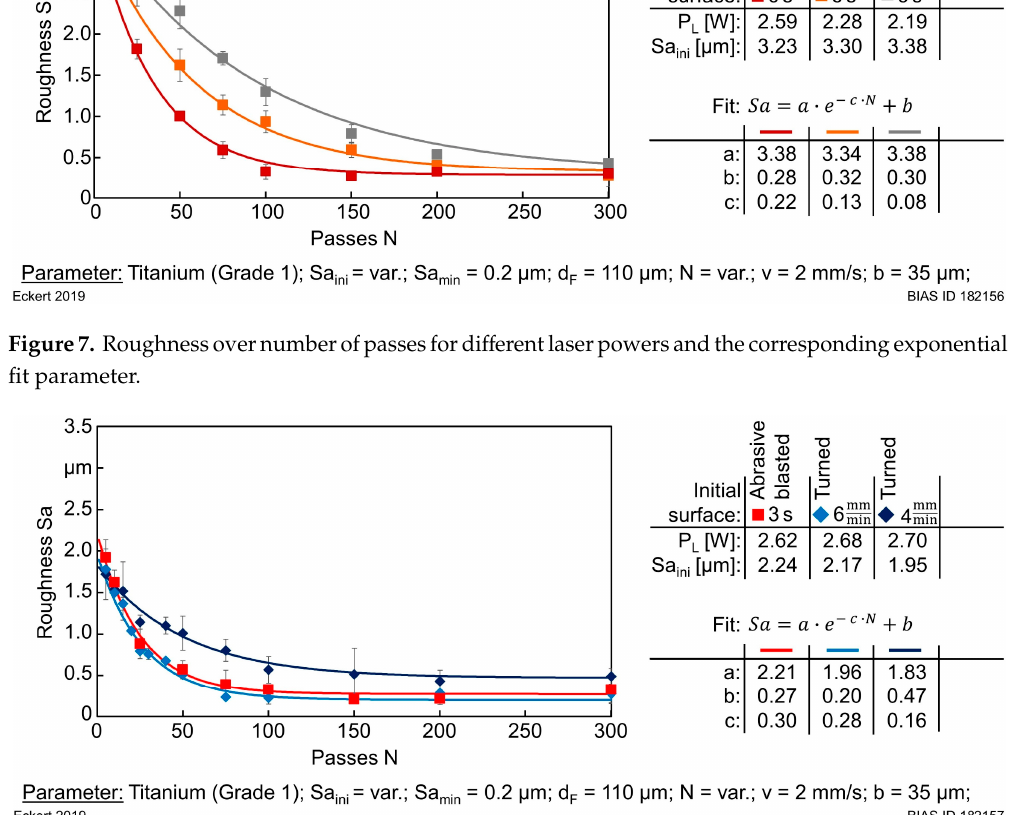
Figure 7. Roughness over number of passes for different laser powers and the corresponding exponential fit parameter.